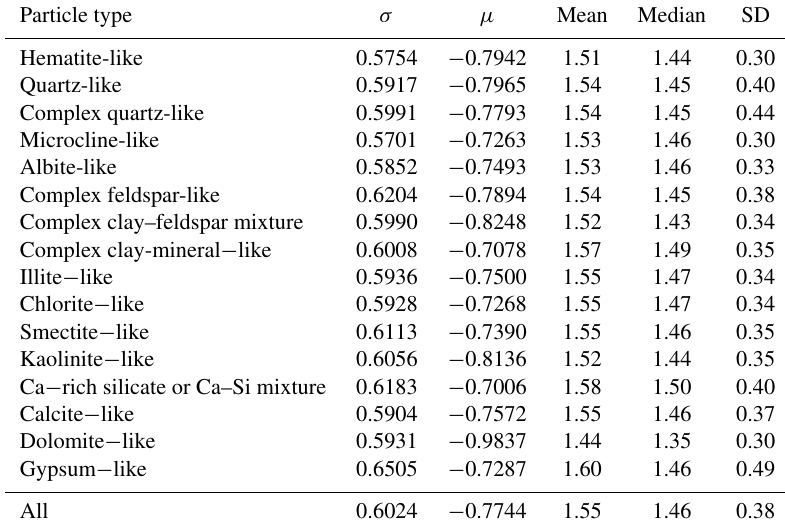
Table 2. Parameters of the aspect ratio density distribution, mean, median, and standard deviation (SD) for different particle